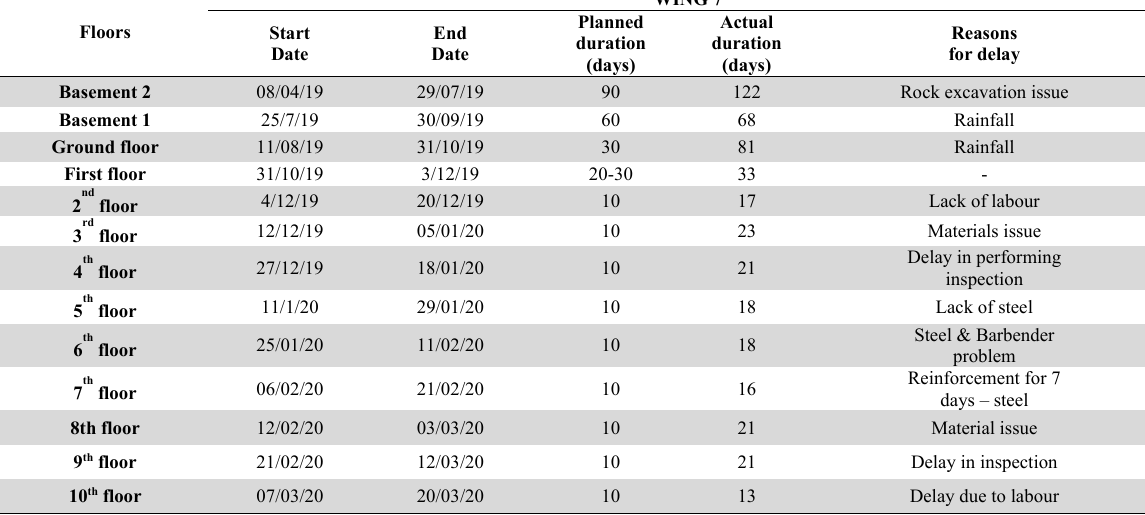
Planned and Actual Duration of Wing